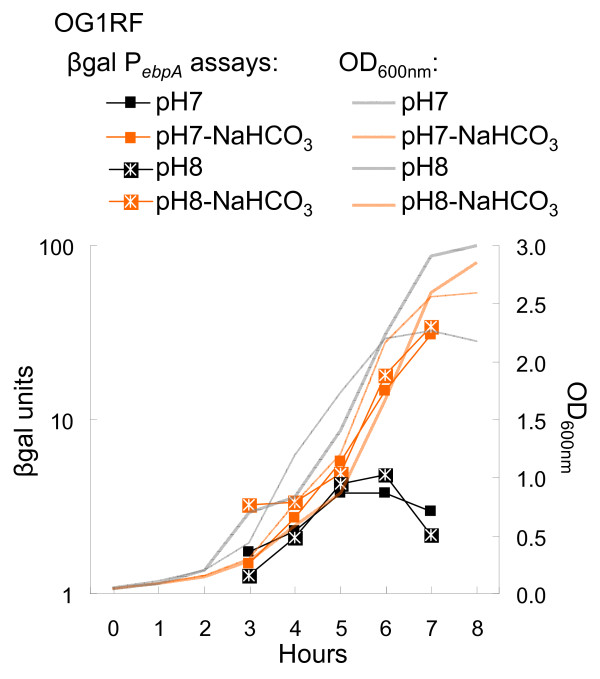
pH and NaHCO3 effect on ebpA expression. OG1RF containing PebpA::lacZ was used in these experiments. Growth curves are represented in thin gray line for pH 7 aerobically, thin orange line for pH 7-Air/NaHCO3, dense gray line for pH 8 aerobically, and dense orange line for pH 8-Air/NaHCO3. All sets of cultures presented were analyzed concurrently. This figure is a representative of at least two experiments. A. OD600 nm readings. B. β-gal assays (β-gal units = OD420 nm/protein concentration in mg/ml).